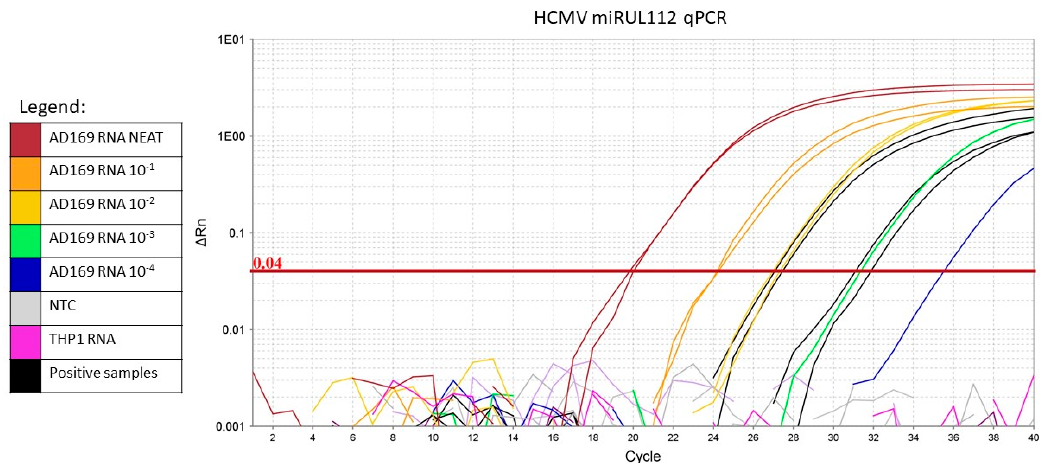
Figure 1. Representative amplification curve from HCMV miR-UL112 qPCR. Coloured curves represent 10-fold dilutions of AD169 RNA. Black curves represent positive samples. No-template control (NTC) and uninfected THP1 RNA are shown in grey and pink, respectively, and do not form curves as no amplification occurred. The horizontal red line represents the threshold.